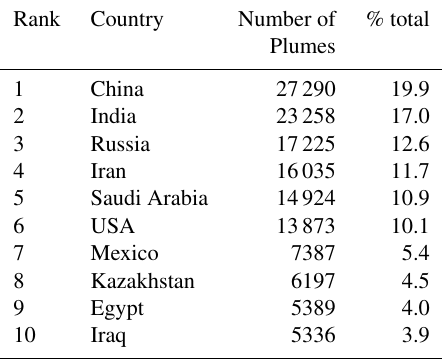
Table 1. Top 10 countries containing the most fossil fuel